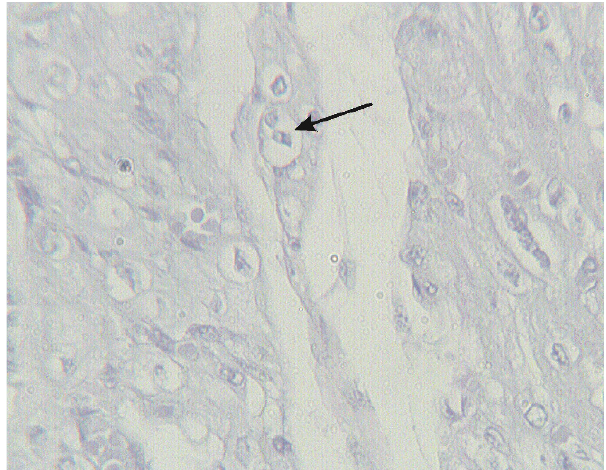
Figure 5 - Cytoplasmic vacuolization of the cardiomyocytes.